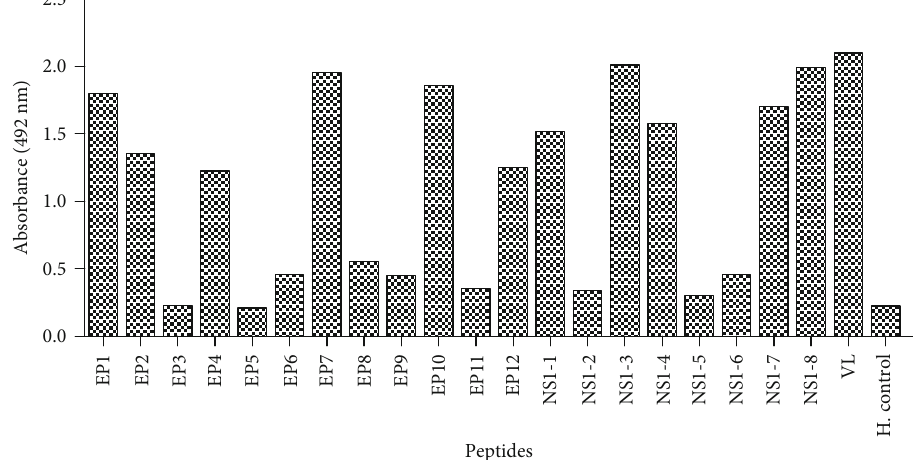
Figure 1: IgM reactivity from the pooled sera of DENV ( n = 25 ) patients with synthetic peptides of E and NS1 proteins and virus lysate (VL, positive control) of dengue virus. Reactivity was compared with pooled sera of healthy individuals ( n = 10 ) (negative control).